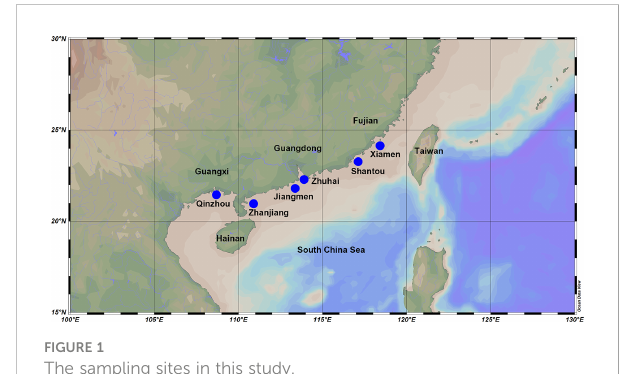
FIGURE 1 The sampling sites in this